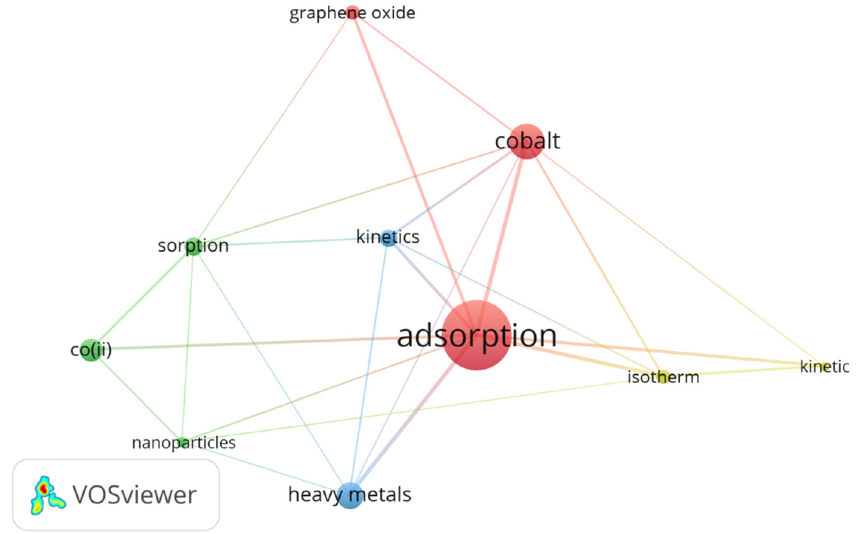
Figure 5. Network visualization of top 10 co-occurring authors’